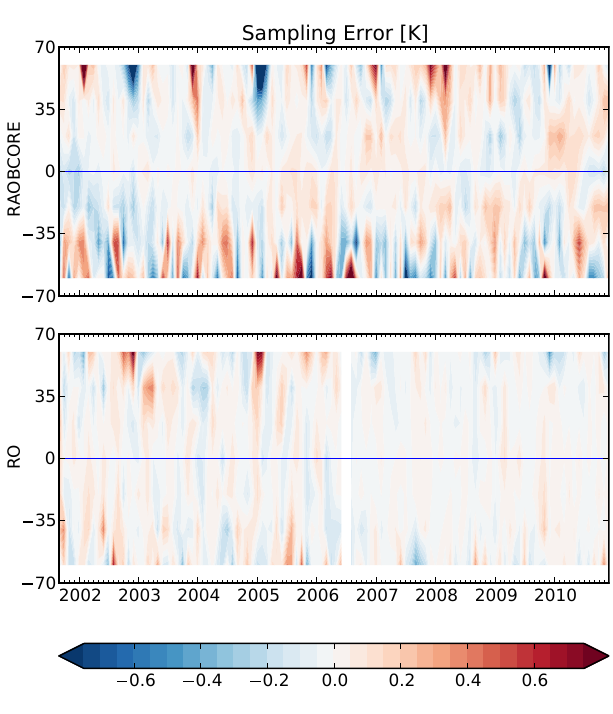
Fig. 5. Sampling error of (top) radiosondes and (bottom) RO. Shown are latitudinal bands at 20 ◦ resolution.